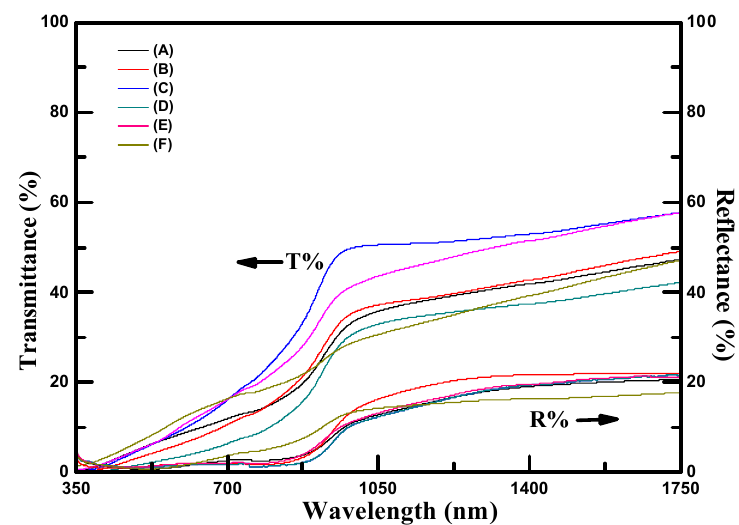
Figure 3. Transmittance and reflectance spectra versus light wavelength for all samples.